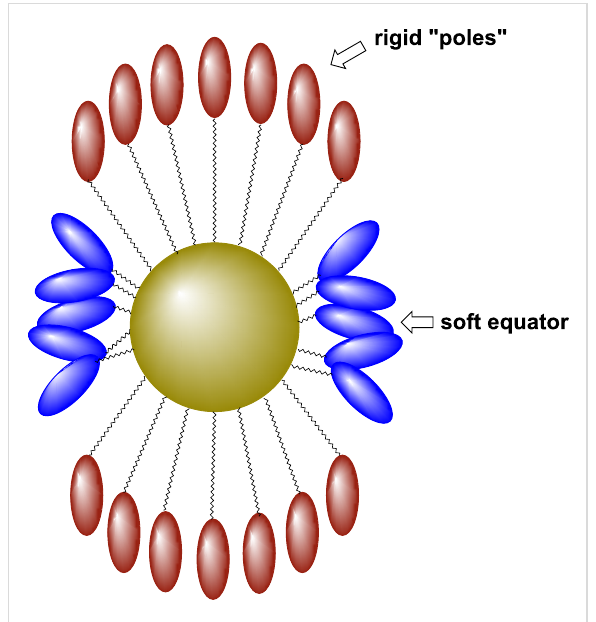
Figure 6: Ligand deformation at the surface of the gold NPs giving rigid "poles" and a soft equator. Such deformations impart the neces- sary anistropy to the system to impart LC behaviour. Adapted from [62].